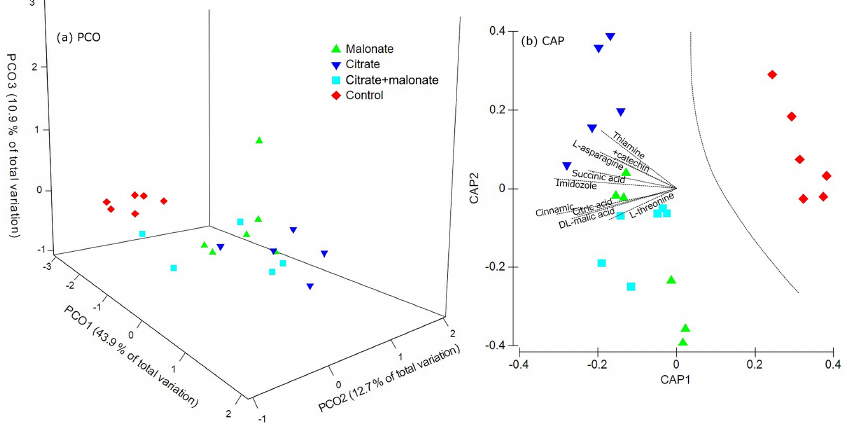
Figure 2. (a) Principal coordinate analysis ordination (PCO) and (b) canonical analysis of principal coordinates (CAPs) of CLPP on soil after 18 days of incubation for diesel-contaminated and uncontaminated soils which received water (control) or 5µmolg − 1 soil of citrate, malonate, or citrate + malonate every 48h. As there was no effect of diesel contamination, there is no distinction made between the three replicates of each carboxylate treatment from diesel-contaminated soil and the three replicates from uncontaminated soil. The curve in (b) represents a significant difference ( P Perm = 0.004 based on PERMANOVA) between treatments receiving carboxylates and the water